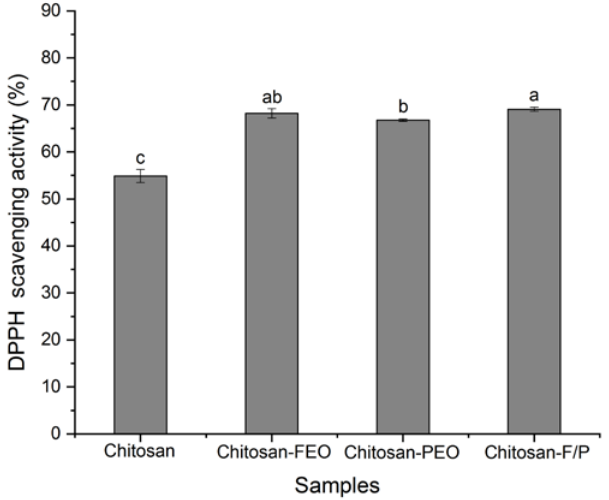
Figure 4. DPPH scavenging activities of Chitosan, Chitosan-FEO, Chitosan-PEO, and Chitosan-F / P films. Di ff erent letters in the same column indicate significantly di ff erent ( p <